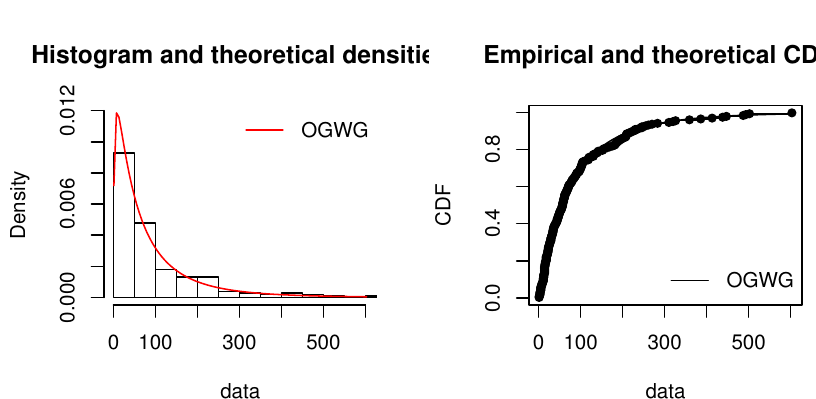
Figure 4. PP, QQ, epdf and ecdf plots of the OGWG distribution for data set